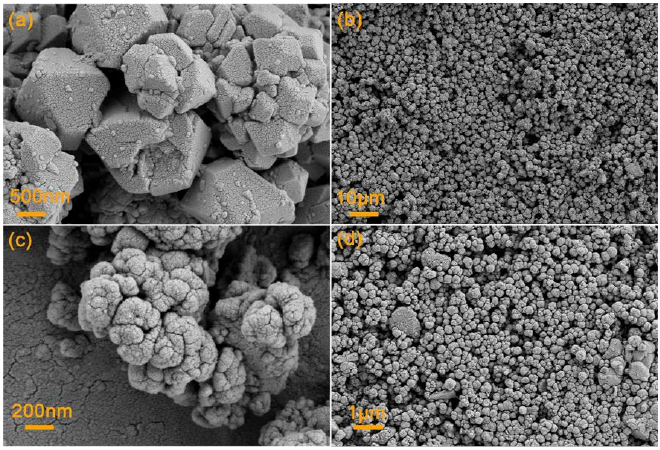
Figure 4. SEM images of ( a , b ) BiVO 4 and ( c , d ) Ag/BiVO 4 functionalized ceramic tiles obtained at 550 °C.